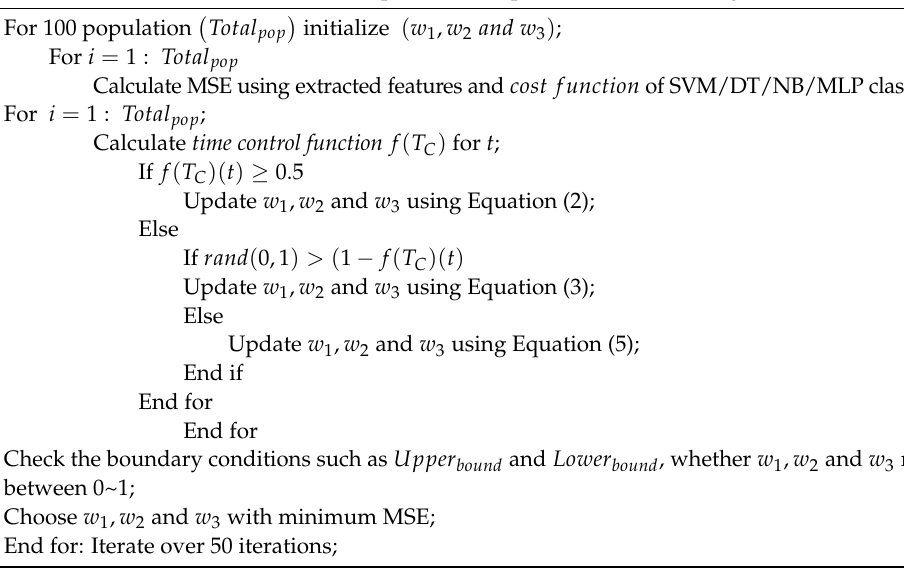
Algorithm 1 MOWFS and FOWFS : Optimized deep feature fusion